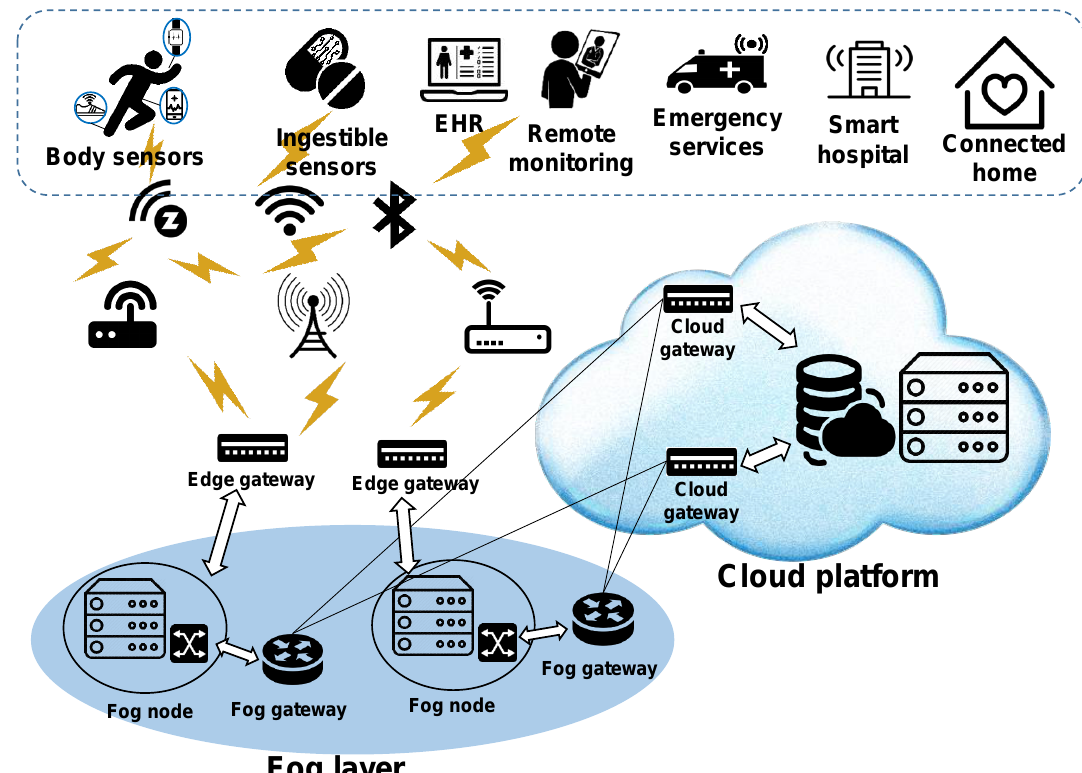
Figure 1. An overview of a typical IoT and cloud computing-based healthcare